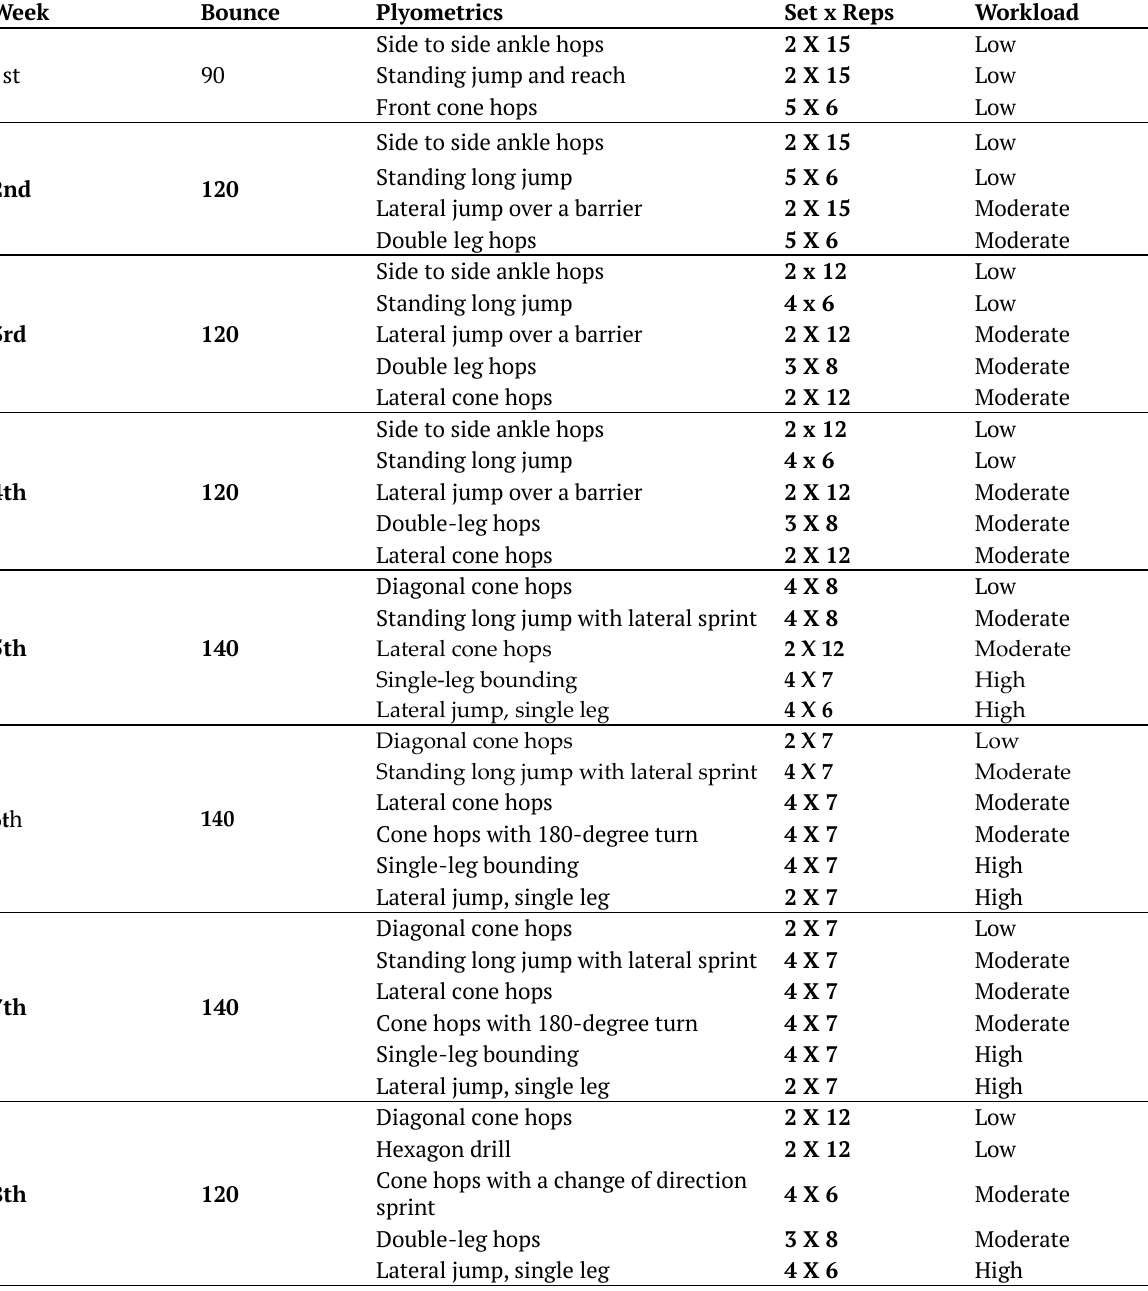
Table 1. Training programme